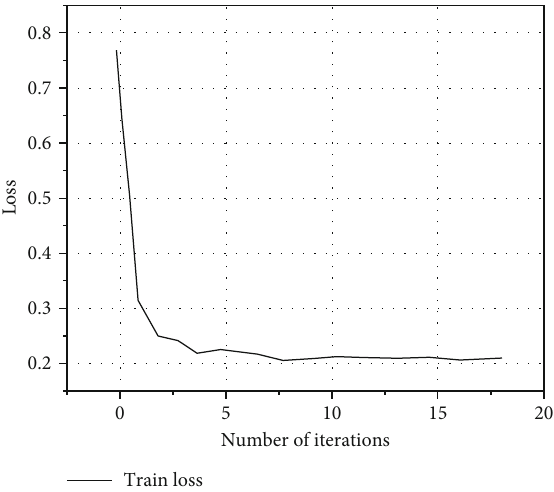
Figure 15: Training model loss